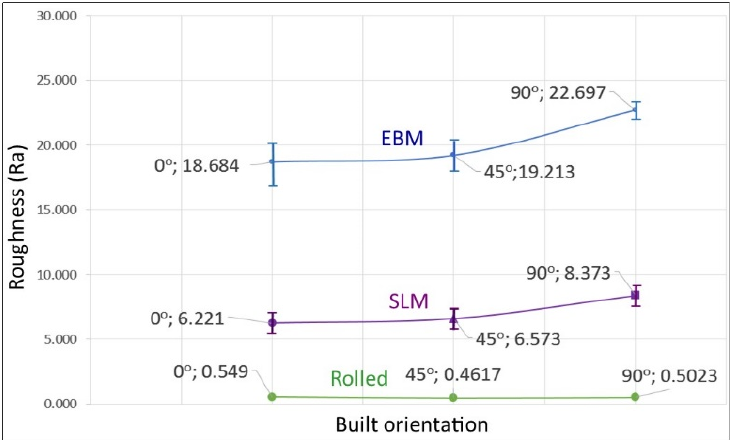
Figure 4. Surface roughness, Ra, values (in μ m) of EBM and SLM samples built in different orientations. Note: the wrought sample was rolled in longitudinal direction and were cut in 0° (longitudinal/horizontal), 45° and 90° (transverse) directions.